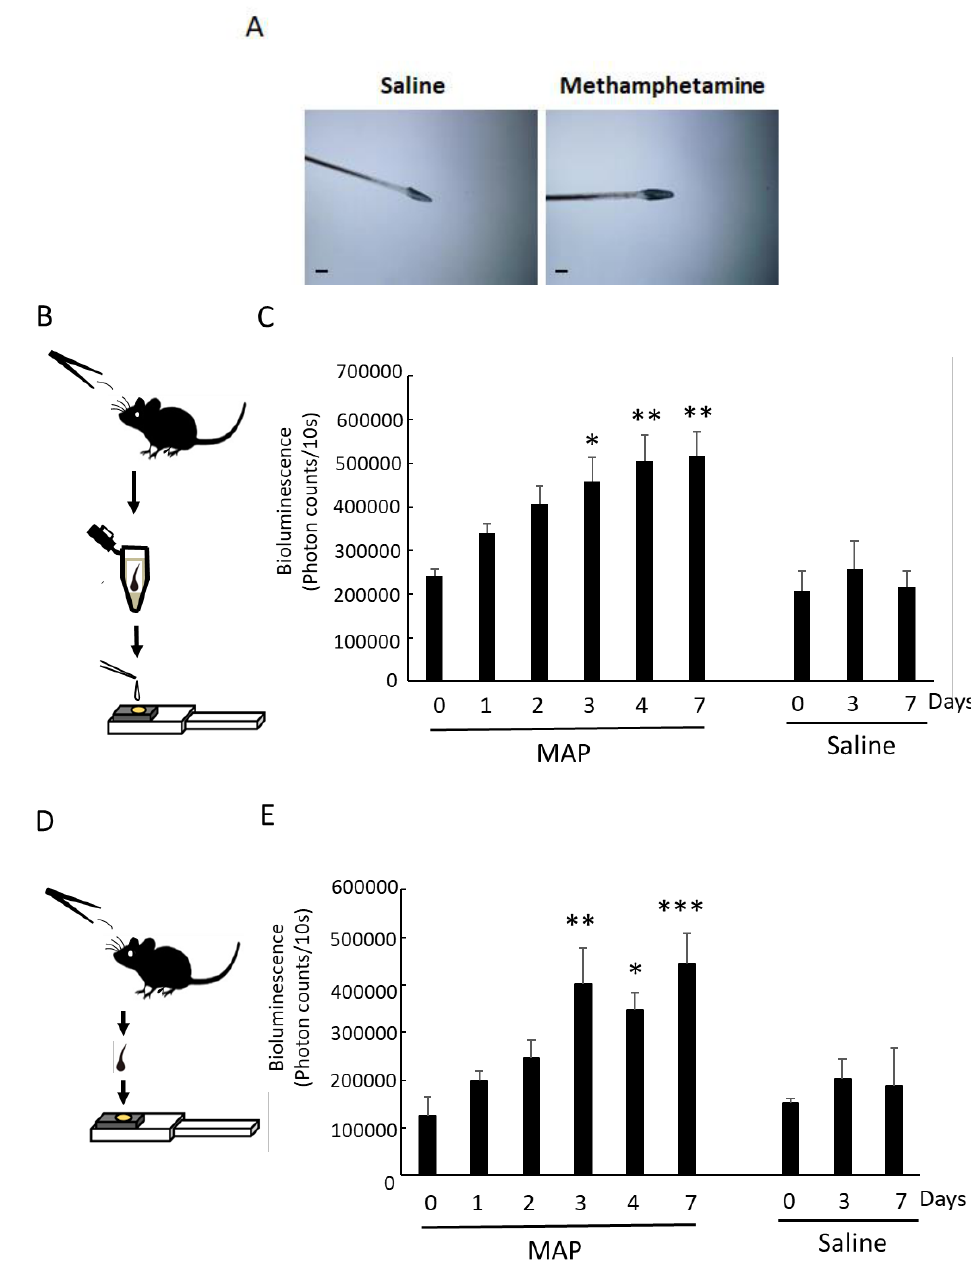
Figure 3. MAP-induced Per1 gene expression in whisker hairs. ( A ) Expression of Per1 in whisker hairs. The hairs were sampled at ZT3 on day 7. The photos indicate the immunostaining with LUC polyclonal antibody. The scale bar is 200 µ m. ( B ) Schematic figure of the solution method for measuring Per1 expression in whisker hairs. ( C ) MAP-induced Per1 gene expression in whisker hairs, determined by the solution method. Bioluminescence was measured every 10 s using a micro-PMT system [13]. The supply voltage was set to 1100 V in order to obtain sufficient bioluminescence. Statistical significance was determined by one-way ANOVA followed by Dunnett’s test ( n = 4 animals) (* p < 0.05, ** p < 0.01 vs. day 0). The day 0 sample was collected just before MAP injection. ( D ) Schematic figure of the direct method for measuring Per1 expression in whisker hairs. ( E ) MAP-induced Per1 gene expression in whisker hairs, determined by the direct method. Statistical significance was determined by one-way ANOVA followed by Dunnett’s test ( n = 4 animals) (* p < 0.05, ** p < 0.01, *** p < 0.001 vs. day 0). The day 0 sample was collected just before MAP